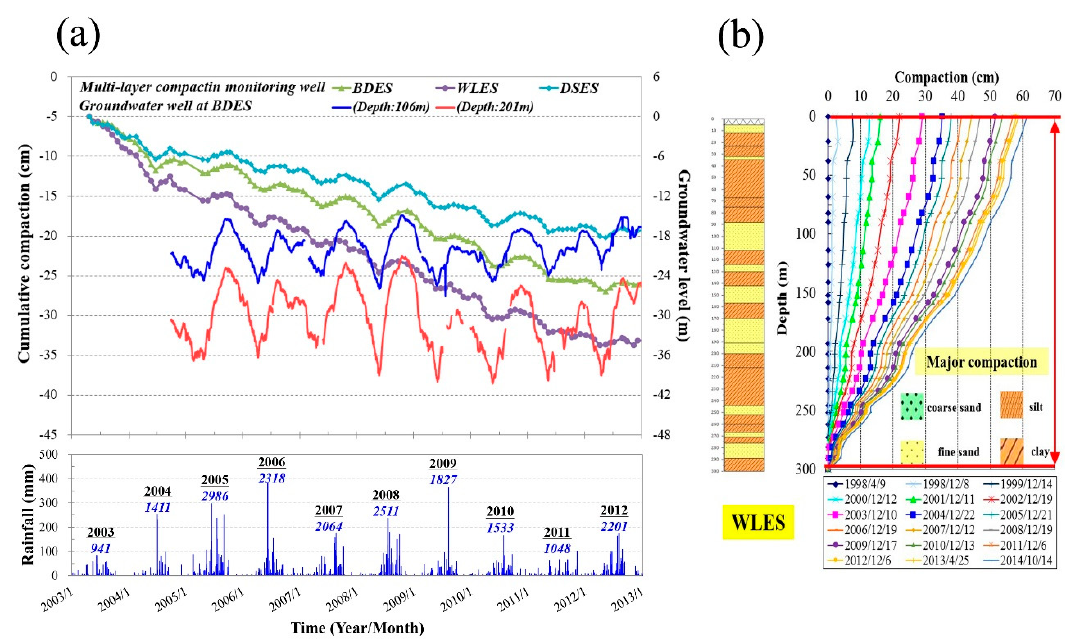
Figure 7. ( a ) Cumulative compactions, groundwater levels and rainfalls at three coastal stations BDES, WLES, and DSES (see Figure 3) ( b ) Cumulative compactions at coastal stations WLES.